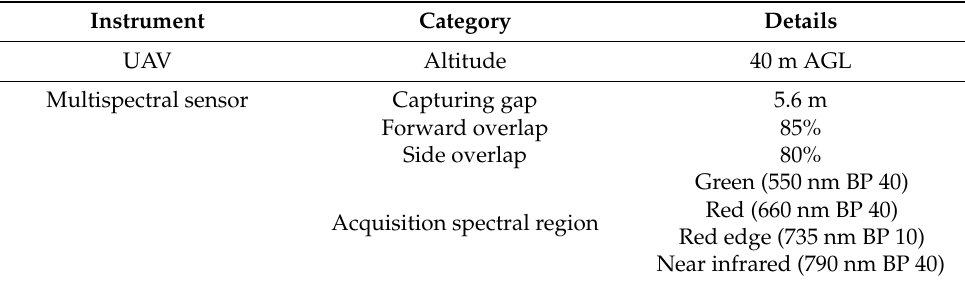
Table 2. Detailed parameters of flight mission and image